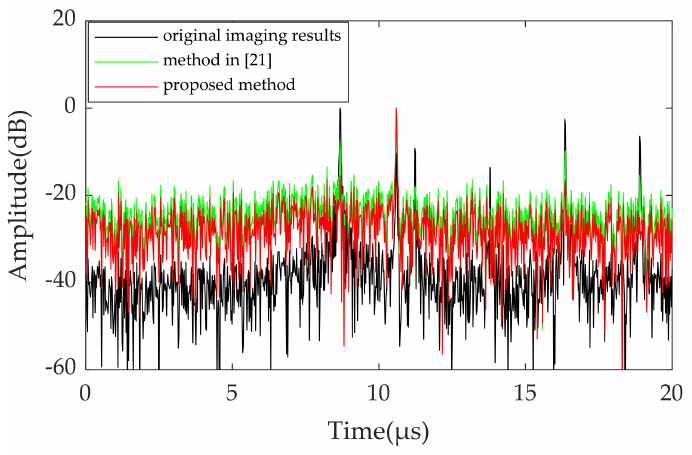
Figure 10. Comparison of image results before and after jamming suppression with different